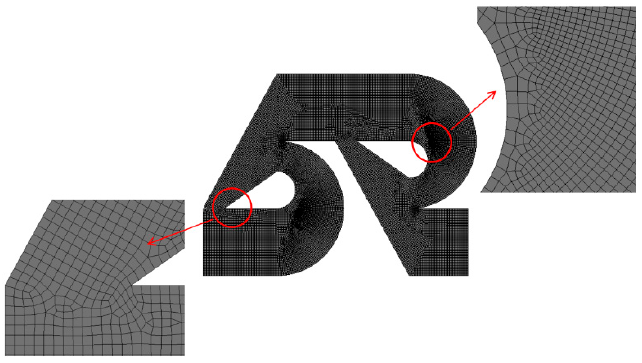
Figure 5. Grid for a modified Tesla mixing unit.